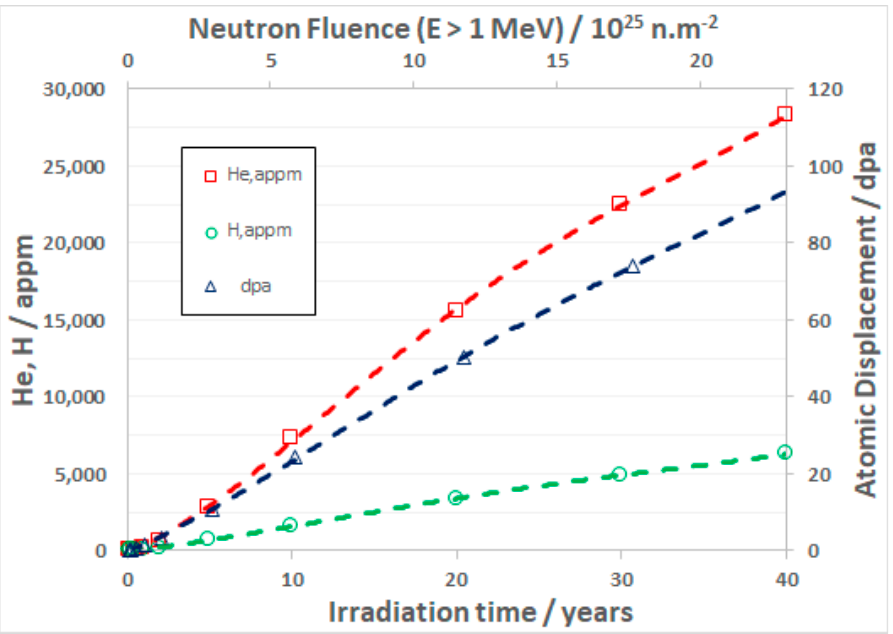
Figure 5. Core average atomic displacements and gas production for Inconel X-750 in a CANDU-6 reactor for an average power as a function of operating time. The corresponding fast neutron fluence (E > 1 MeV) is shown on the secondary horizontal axis.